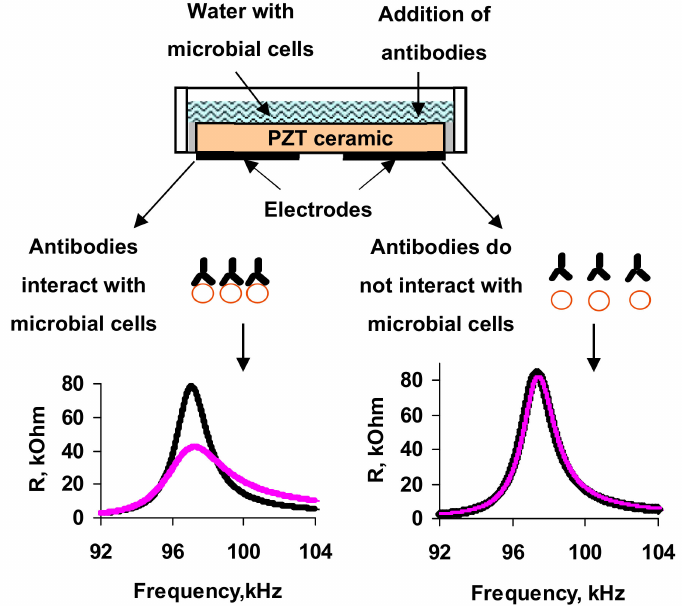
Figure 1. The general scheme of the